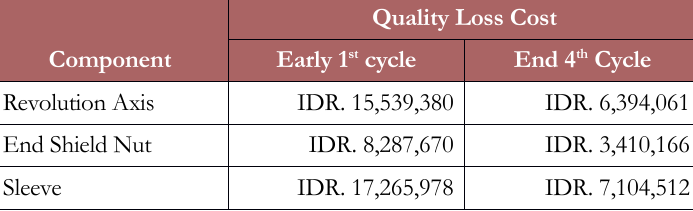
Table 14. Reduction of quality loss in manufacturer side